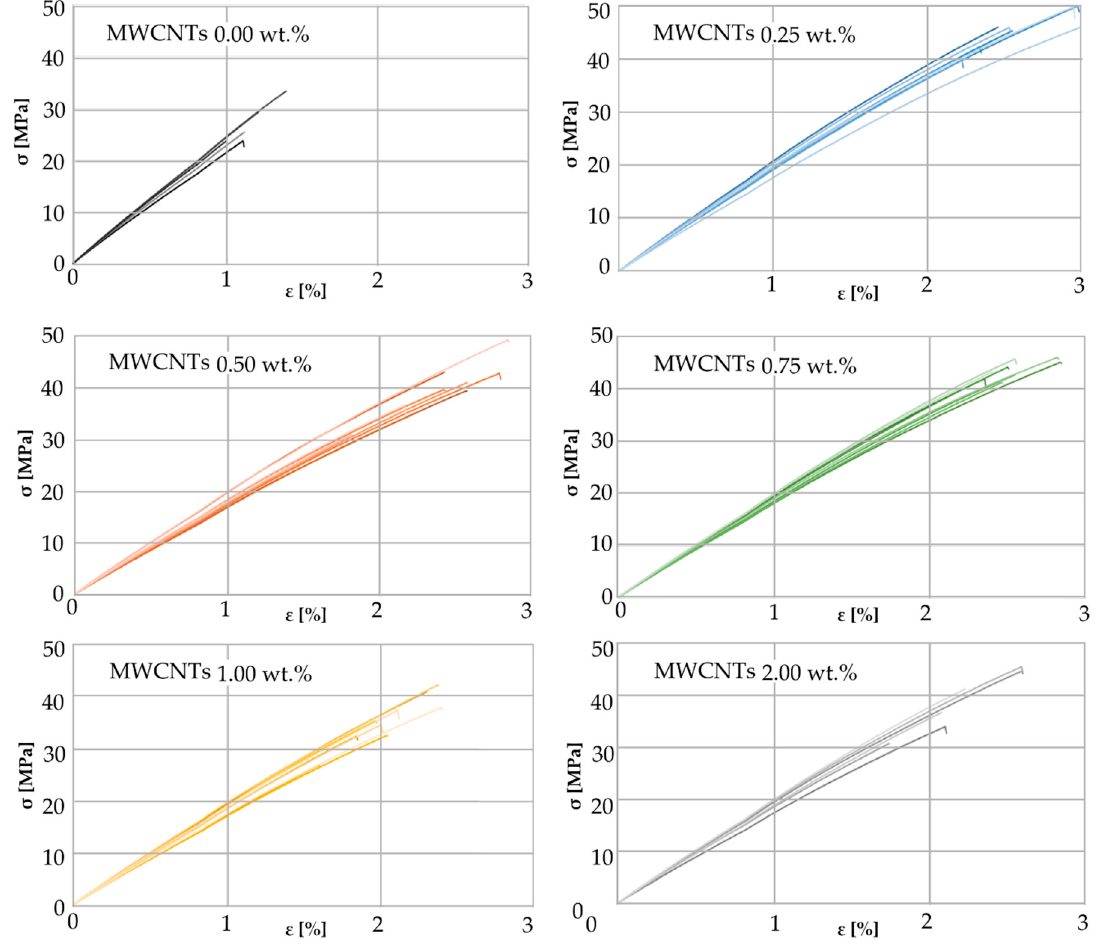
Figure 6. Stress–strain curves for different MWCNTs mass fractions.